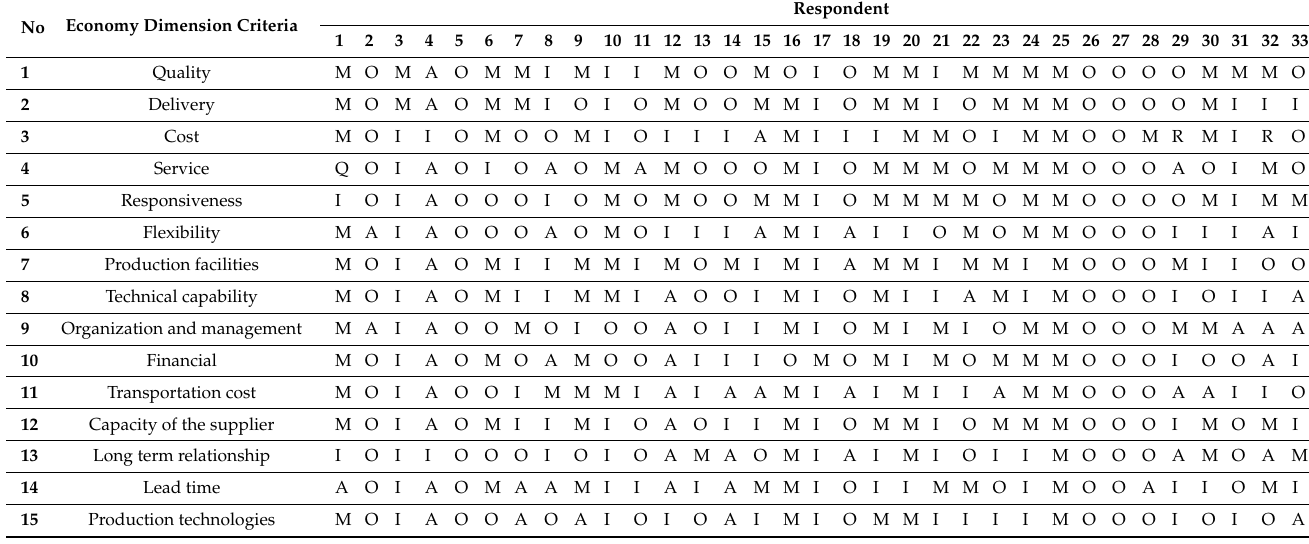
Table A1. The Kano Evaluation Table.